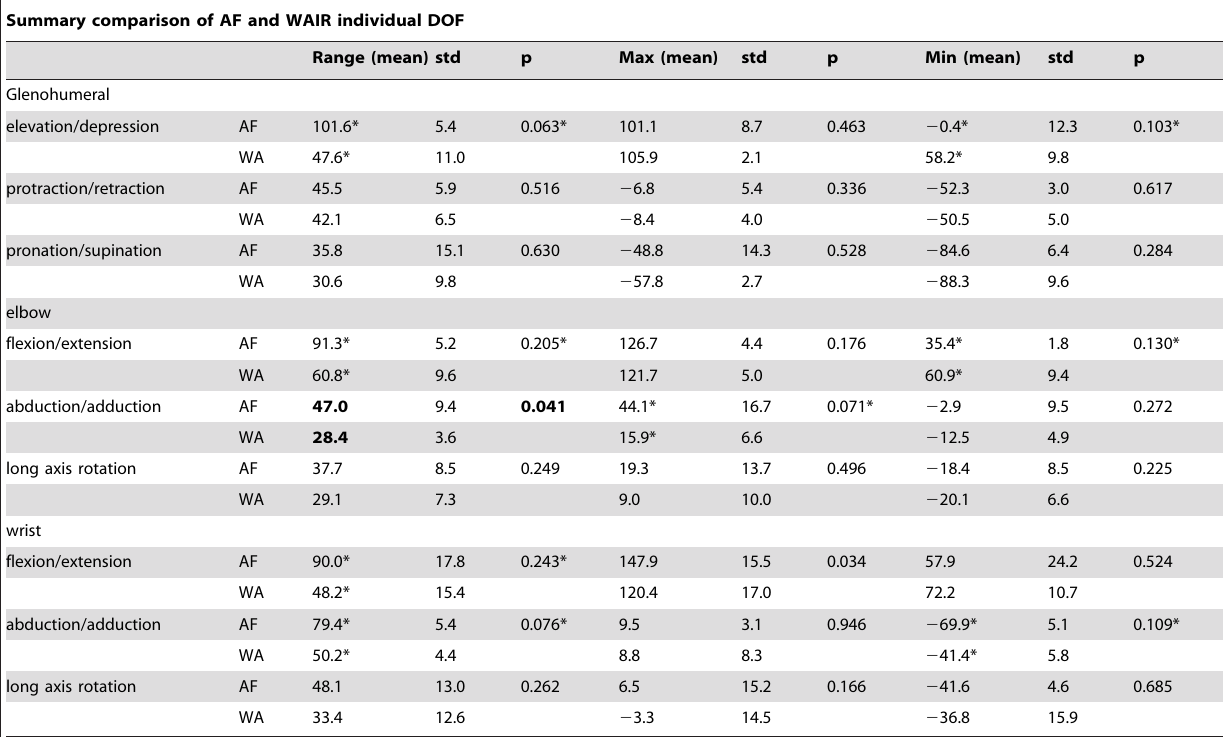
Summary comparison of AF and WAIR individual